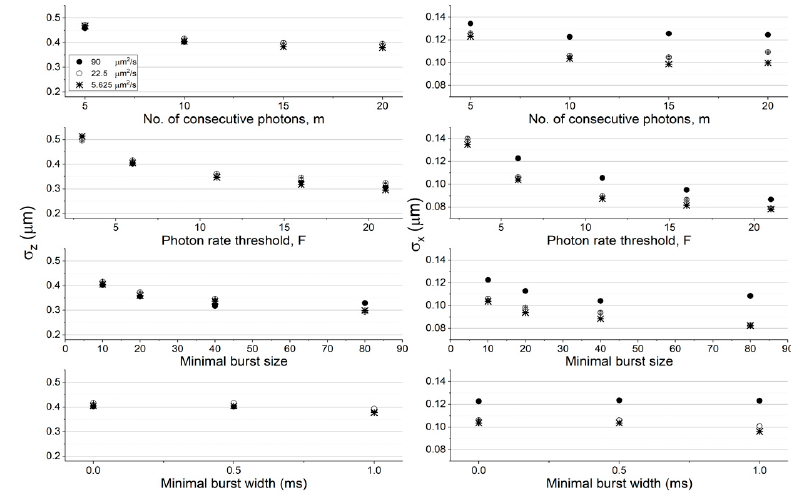
Figure 4. The molecular position dispersion as a function of burst search criteria and experimental conditions (different diffusion coefficients). Shown are the standard deviation of molecular positions in the z (left) and x (right) coordinates (the values in the y coordinate are the same as the ones in the x coordinate, in within the error ranges), when they emitted photons that were detected and selected by the burst analysis. The error values were calculated as the uncertainty of the standard deviation. All values are reported in Table S2. The assessment of the molecular position dispersion here is shown as a function of molecules diffusing with different diffusion coefficients, at a constant concentration (62 pM), and in simulations using the numerical PSF model.